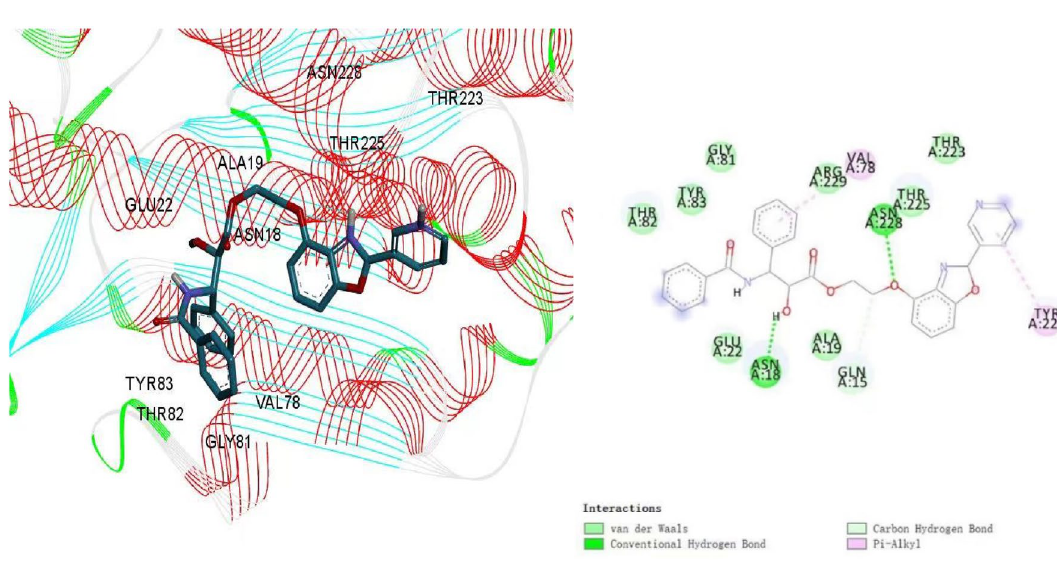
Figure 4. The molecular docking result and pattern of compound 7g and